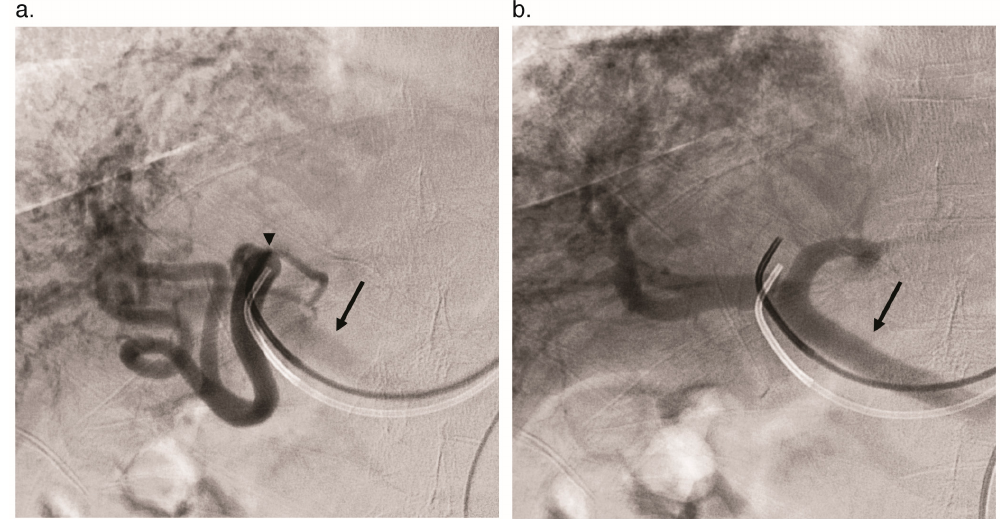
Arterioportal shunt angiography in a 69-year-old woman with HHT. ( a ) Selective catheterization and injection of the hepatic artery (arrowhead) shows dilation of the hepatic arterial system and early contrast opacification of the main portal vein (arrow). ( b ) Portal venous phase shows further opacification of the main portal vein (arrow) and intrahepatic portal veins.